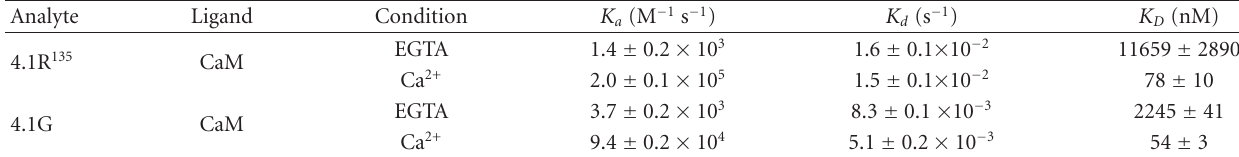
Table 2: 4.1R 135 and 4.1G binding to